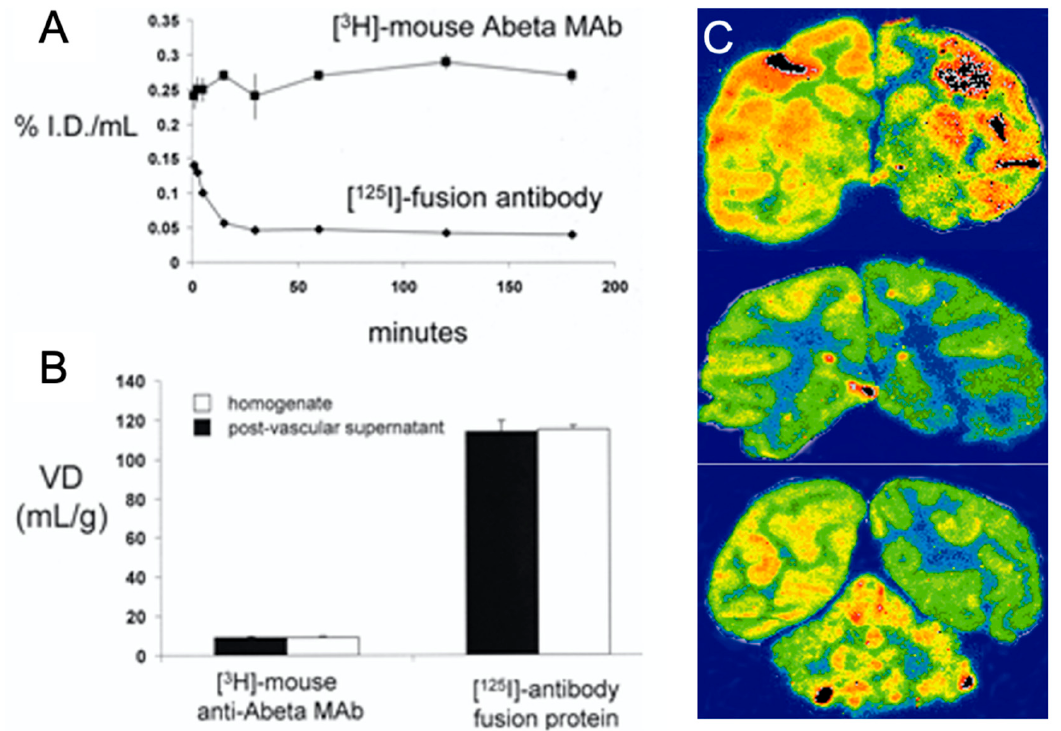
Figure 8. Pharmacokinetics and brain uptake of a tetravalent bispecific MAb fusion protein in the rhesus monkey. The structure of the tetravalent bispecific MAb fusion protein is shown in Figure 7. This fusion protein, designated [ 125 I]-fusion antibody in this figure, comprises the transport domain, which targets the BBB human insulin receptor, and the therapeutic domain, which is a single-chain anti-A β antibody monomer (ScFv). ( A ) Plasma pharmacokinetics analysis showing no measurable clearance from the blood of the control [ 3 H]-mouse Abeta MAb, whereas the [ 125 I]-fusion antibody is rapidly cleared from blood due to uptake via the insulin receptor. ( B ) Brain VD for the [ 125 I]-fusion antibody is >100 µ L/g in both the brain homogenate and the post-vascular supernatant, which indicates the [ 125 I]-fusion antibody is transported across the BBB. The VD for the [ 3 H]-mouse Abeta MAb, 10 µL/g, is equal to the brain arterial blood volume, which indicates this antibody is not transported across the primate BBB in vivo. ( C ) Global distribution of fusion antibody to primate brain. Brain scans of adult rhesus monkey at 3 h after the intravenous administration of the [ 125 I]-fusion antibody demonstrates the widespread distribution of the fusion antibody into the primate brain in vivo. The top scan is the most frontal part of brain, and the bottom scan is the most caudal part of brain and includes the cerebellum. From [29] with permission.